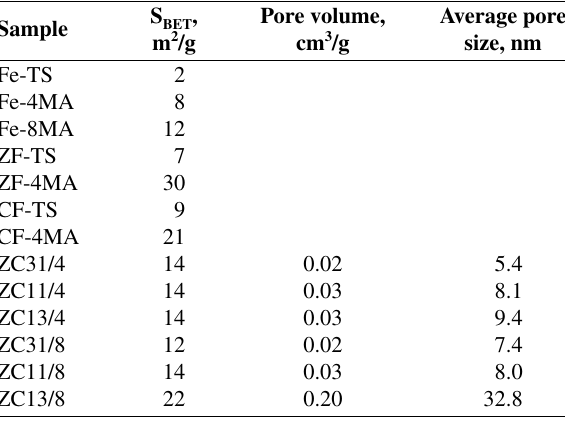
Table 3. Specific surface area (SSA), pore volume and average po- re diameter of the samples